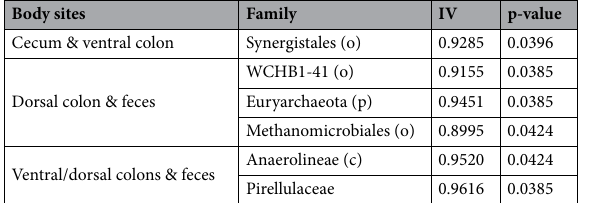
Table 2. Families identified to be most significant indicators based on combinations of body sites, which include the indicator value (IV) and p-value for each. ( o order, p phylum, c